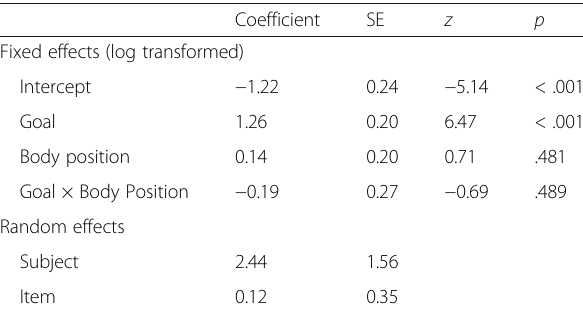
Table 1 Model estimates for logistic linear mixed model predicting segmentation